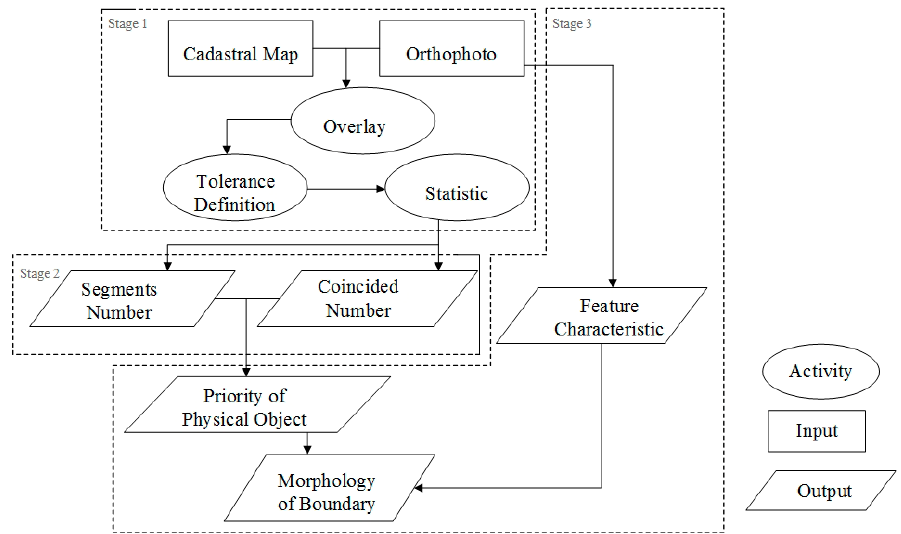
Figure 3. General workflow.